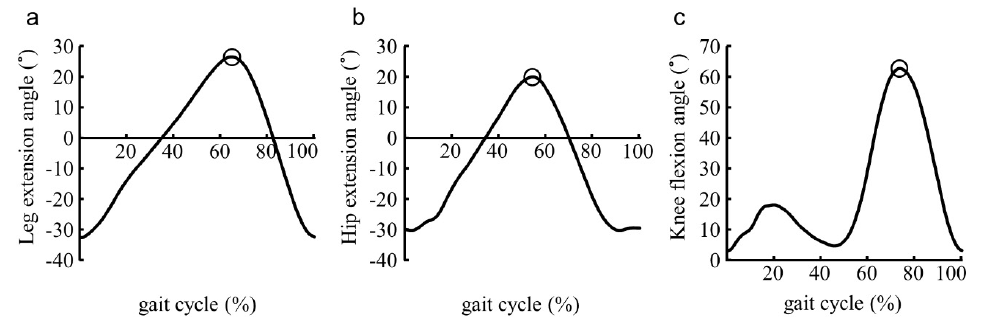
Figure 3. Representative waveform of the lower limb joint angle during gait. ( a ) Leg extension angle and ( b ) hip extension angle during late stance, and ( c ) knee flexion angle at swing phase were calculated from the tilt angle measured by inertial measurement units. Blank circles indicate the maximum value of each angle.